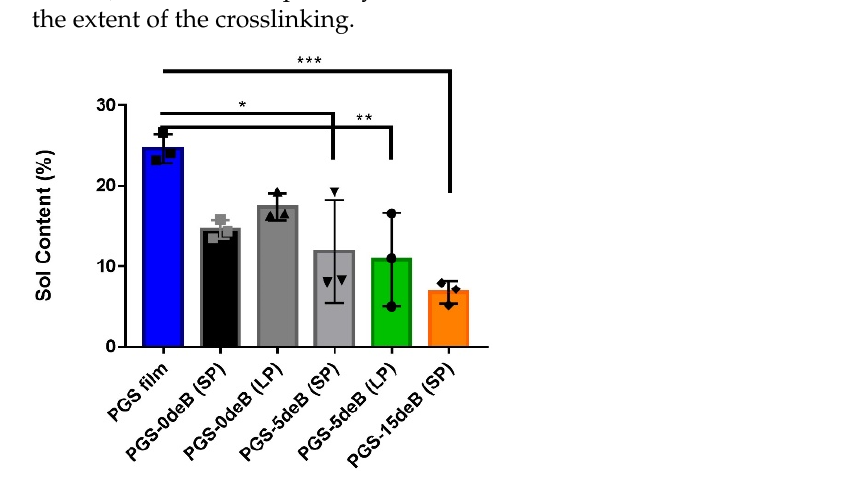
Figure 6. The crosslinking density of all the PGS-deB blend scaffolds and PGS film; the sol fractions % (non-crosslinked content) of the PGS film and PGS-deB blend scaffolds were determined via sol–gel content; * p < 0.05; ** p ≤ 0.01 and *** p ≤ 0.001 indicates statistical significance and each data have plotted as geometrical symbols on bars (n=3).